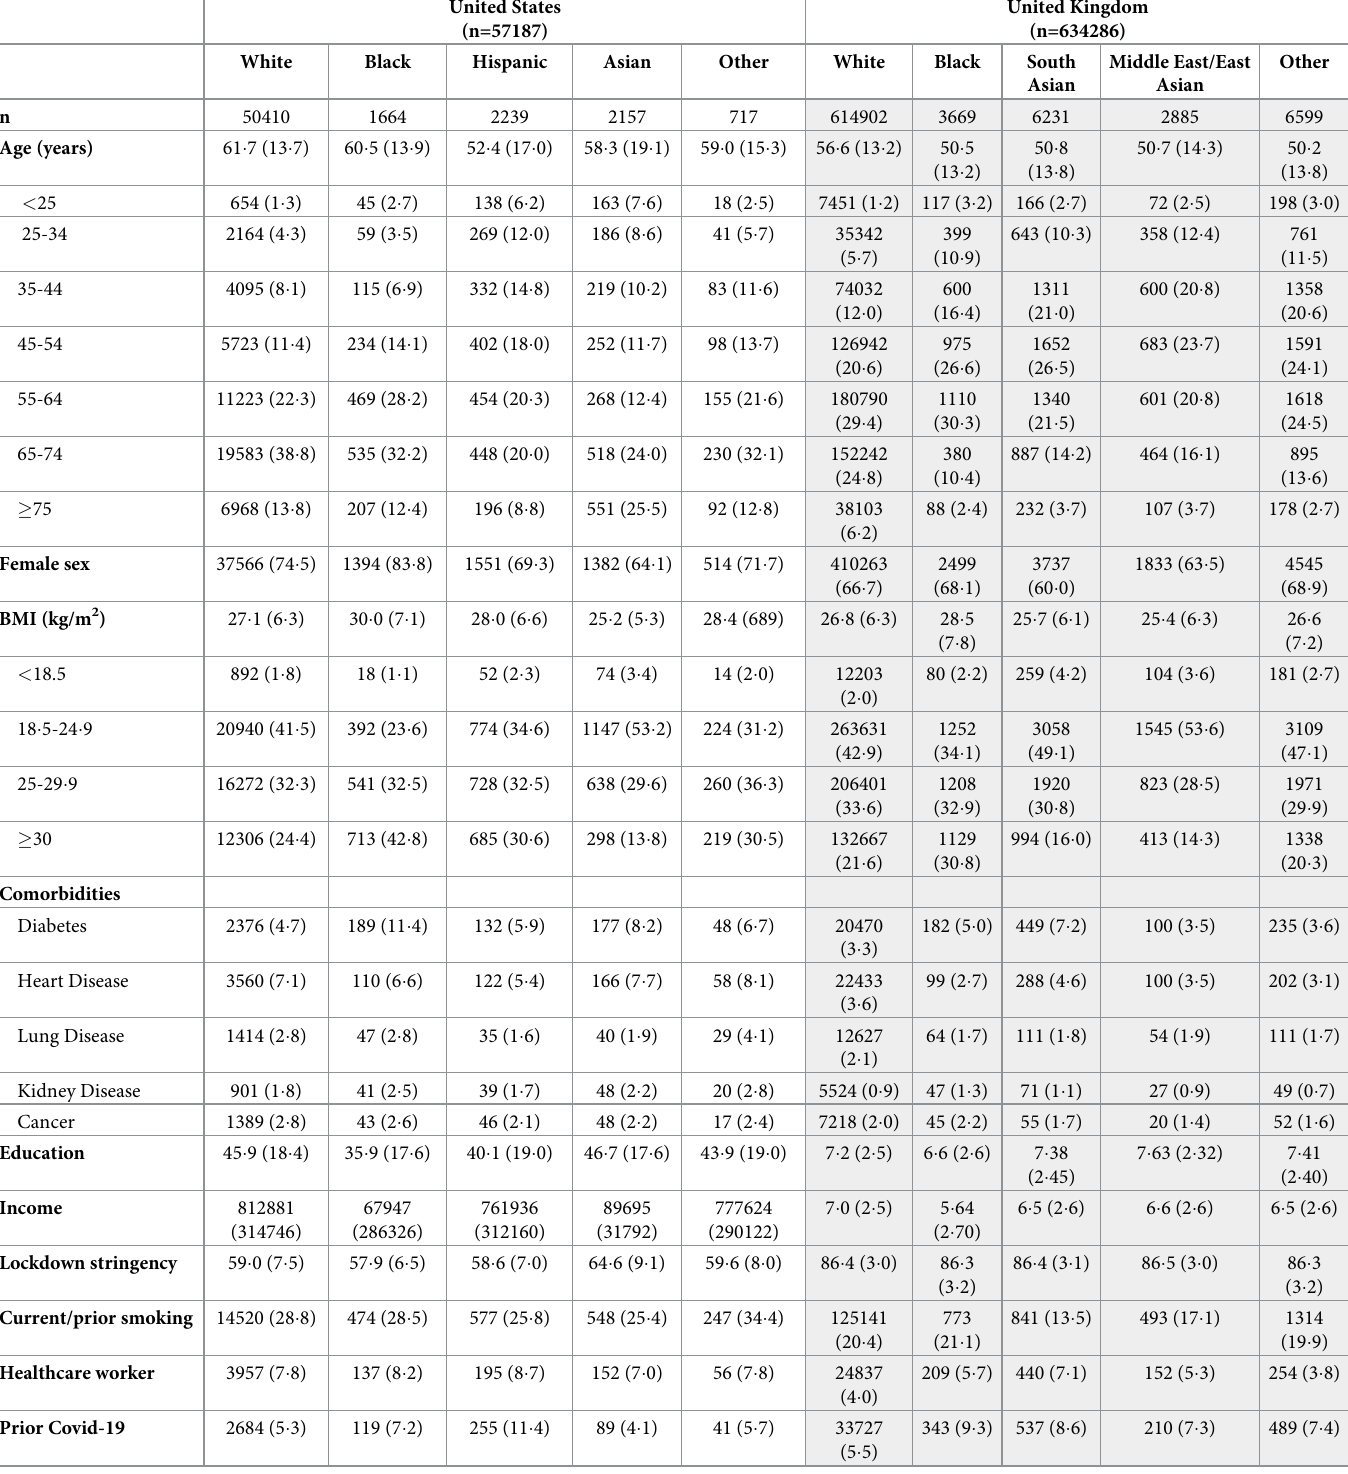
Table 1. Baseline characteristics of study participants by race and ethnicity according to country of